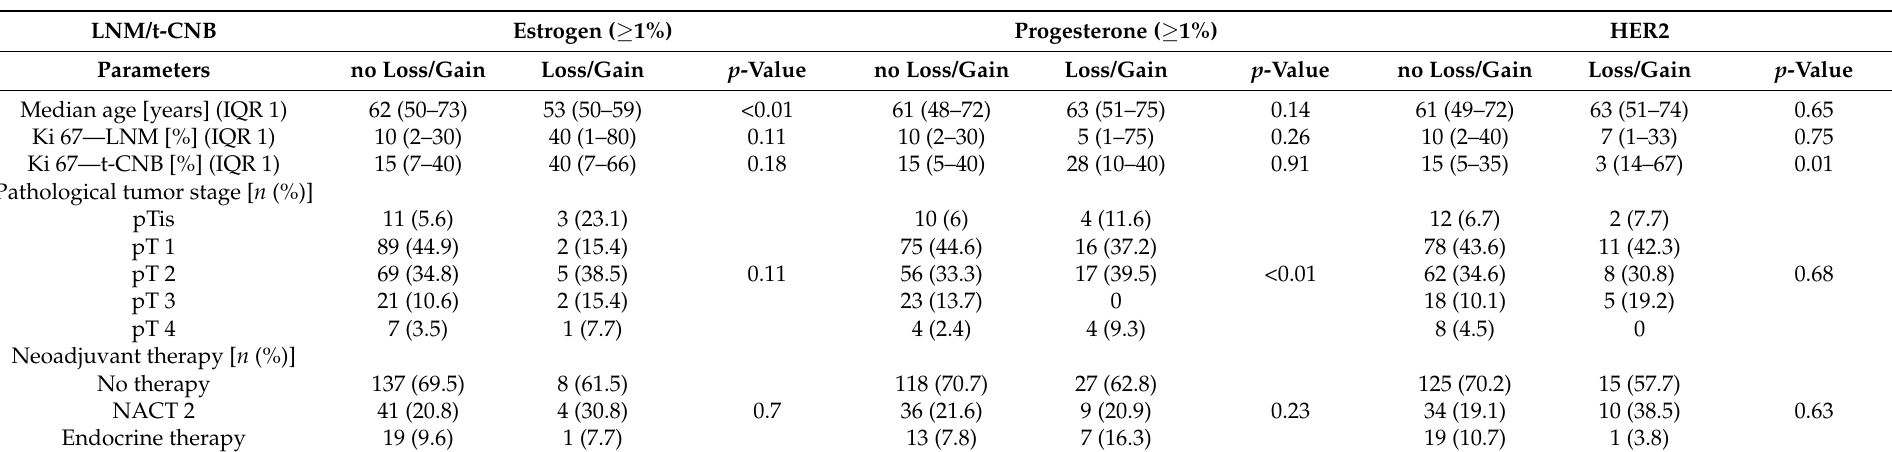
Table 4. Competitive analysis of receptor changes for ER, PR and